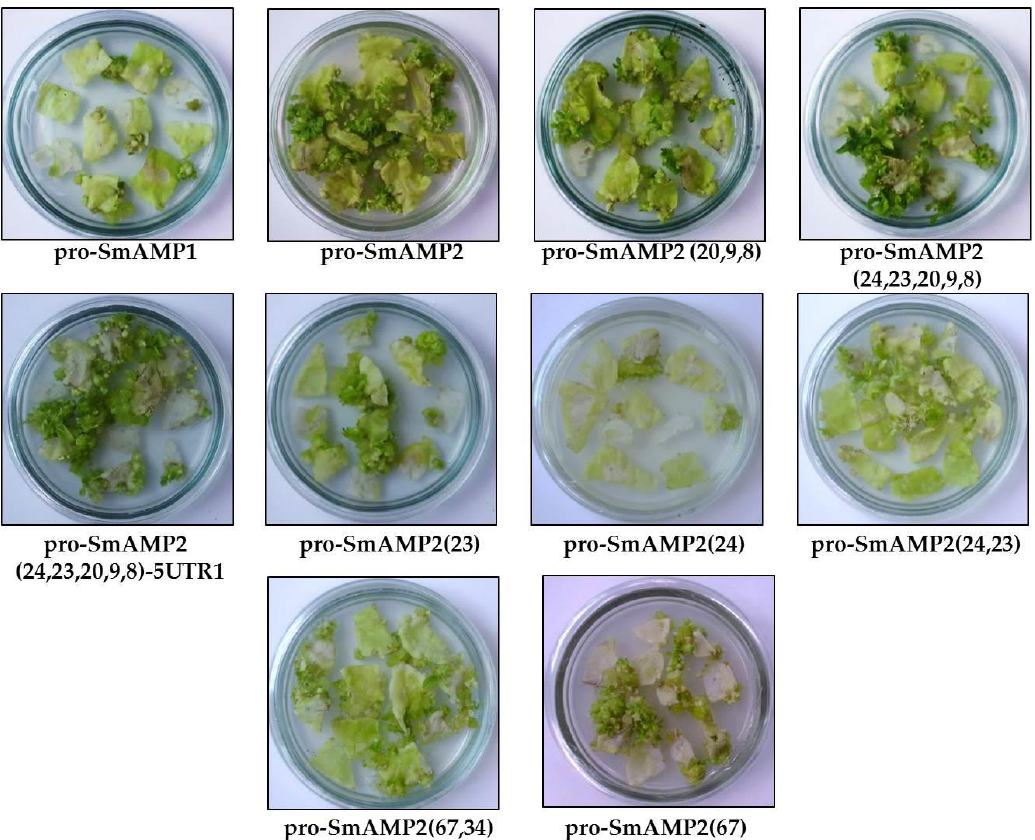
Figure 8. Efficiency of selection of tobacco calli using the intact pro-SmAMP1 (102) and pro-SmAMP2 (104) and synthetic promoters on selective growth medium containing 550 mg / L kanamycin.